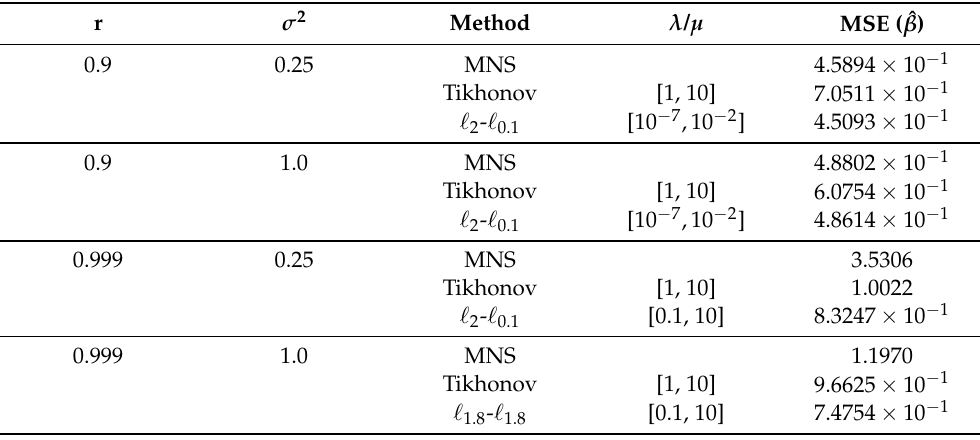
Table 2. Results for X 50 × 101 .